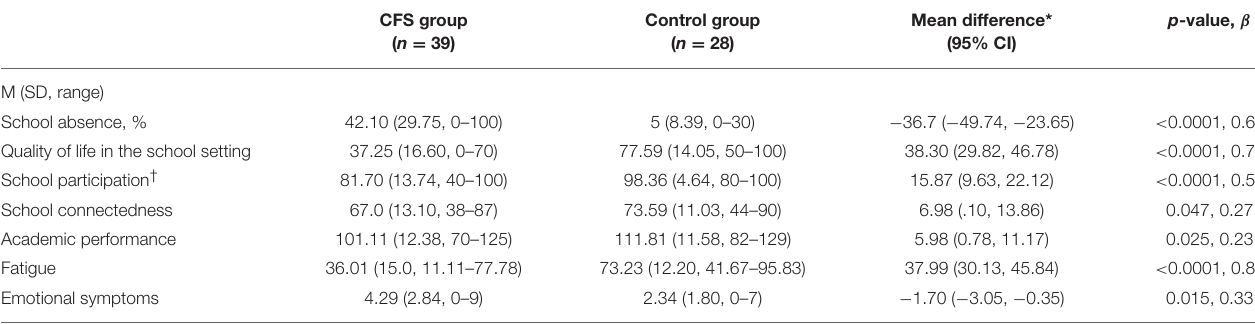
TABLE 3 | Mean differences between CFS group and controls on school functioning, fatigue and emotional symptoms.